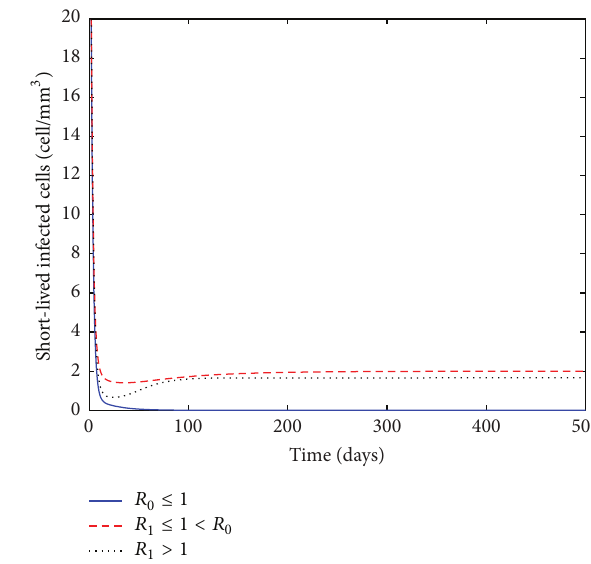
Figure5:Theevolutionofantibodyimmunecellsformodel(2)–(6).